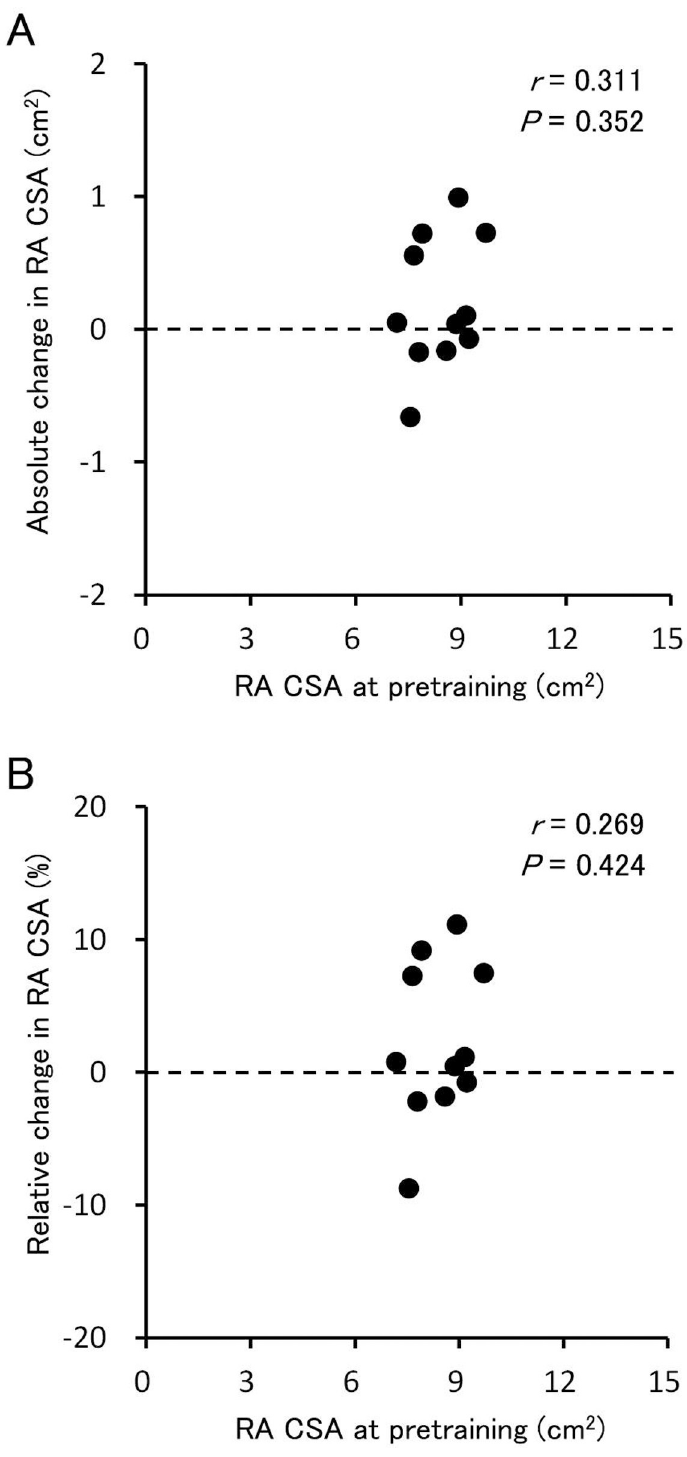
Fig 4. The relationship between cross-sectional area of the rectus abdominis at pretraining and its changes after training. RA, rectus abdominis; CSA, cross-sectional area. (A) The relationship between RA CSA at pretraining and the absolute change in the CSA. (B) The relationship between RA CSA at pretraining and the relative change in the CSA.